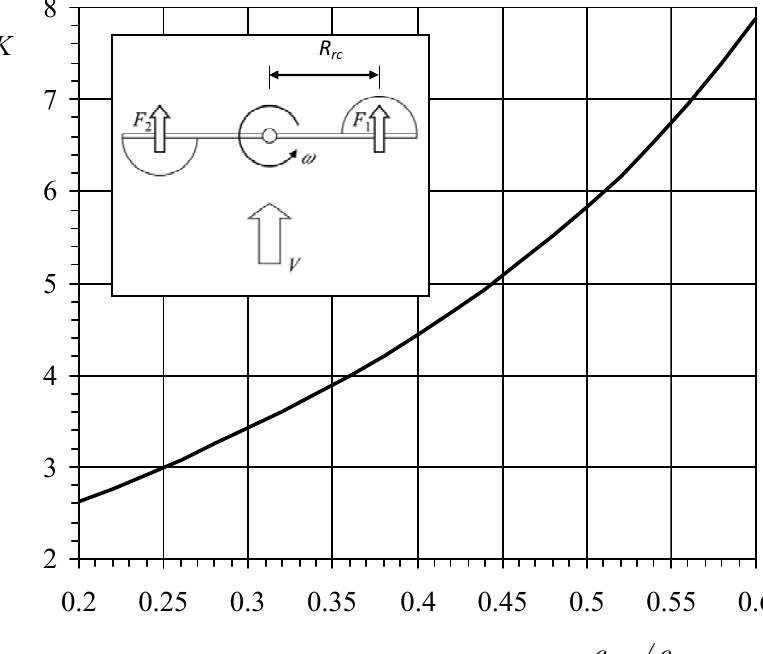
Figure 1. 2-cup anemometer model: anemometer factor (see Section 1.1), K , as a function of the ratio between the aerodynamic drag coefficient of the cups at 0° wind angle, c at 180° wind angle, c d 2